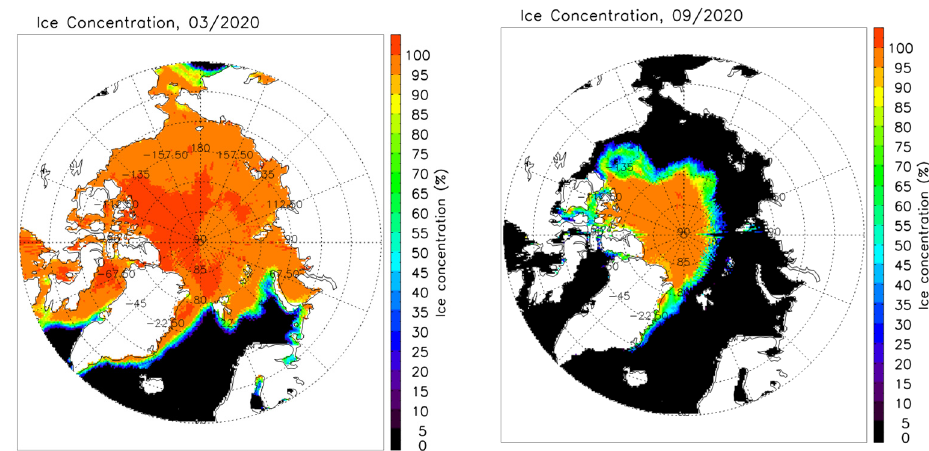
Figure 5. Spatial distribution of Arctic monthly mean SIC in March ( left ) and September ( right ) in 2020 from the NOAA/NSIDC Climate Data Record of Passive Microwave Sea Ice Concentration.